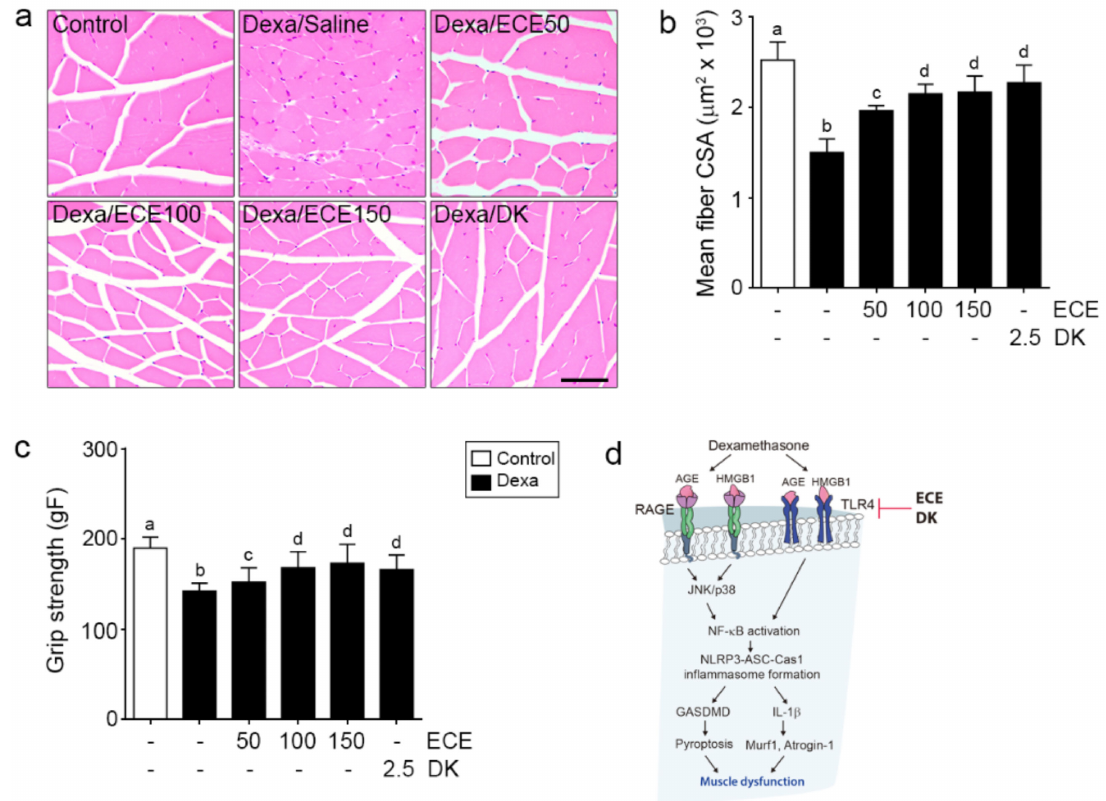
Figure 4. Effects of ECE or DK on recovering muscle strength by reducing pyroptosis in the gastrocnemius muscle of the Dexa-induced muscle atrophy model. ( a ) Representative image of H&E stained cross-sections of the gastrocnemius muscle. ( b ) The mean muscle fiber CSA was decreased by Dexa but increased by ECE and DK. ( c ) Grip strength in the study groups before sacrifice. Grip strength was decreased by Dexa but increased by ECE and DK. ( d ) Summary. The dose unit of ECE and DK is mg/kg/day. a–d: Different letters indicate significant differences among groups as determined by multiple comparison (Mann–Whitney U test); p < 0.05. CSA, cross-sectional area; Dexa, dexamethasone; DK, dieckol; ECE, Ecklonia cava